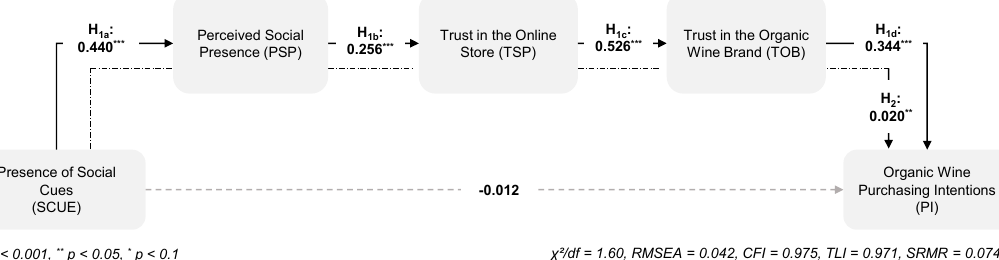
Figure 5. The role of goal-directedness on the effects of the presence of social cues.